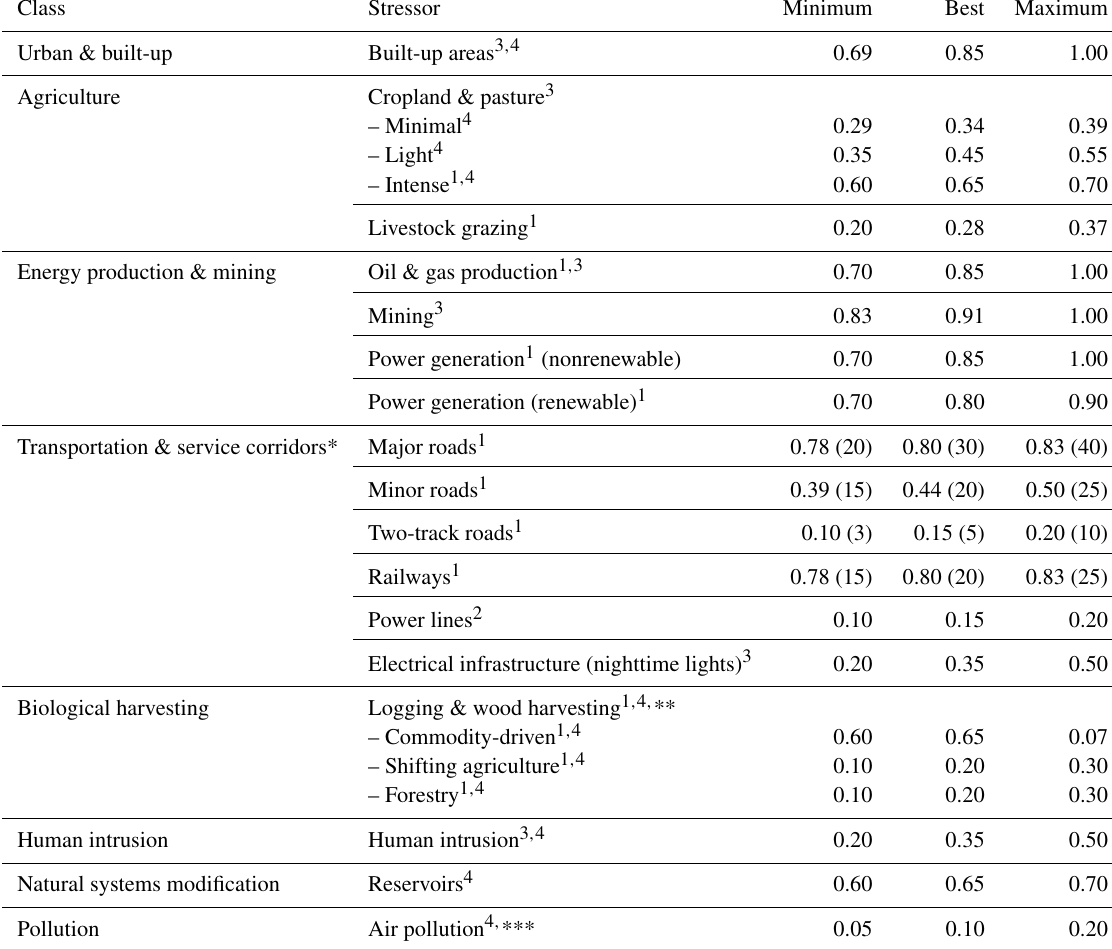
Table 2. Estimates of the intensity value for each stressor. “Best” estimates were determined from Brown and Vivas (2005) 1 , Theobald (2013) 2 , Kennedy et al. (2019b) 3 , or expert judgment 4 and are bracketed by a minimum and maximum range, following the lowest–highest– best-estimate elicitation procedure to reduce bias (McBride et al., 2012). Results presented here use the best estimate, while minimum and maximum estimates are used to specify the range of possible randomized intensity values in the uncertainty